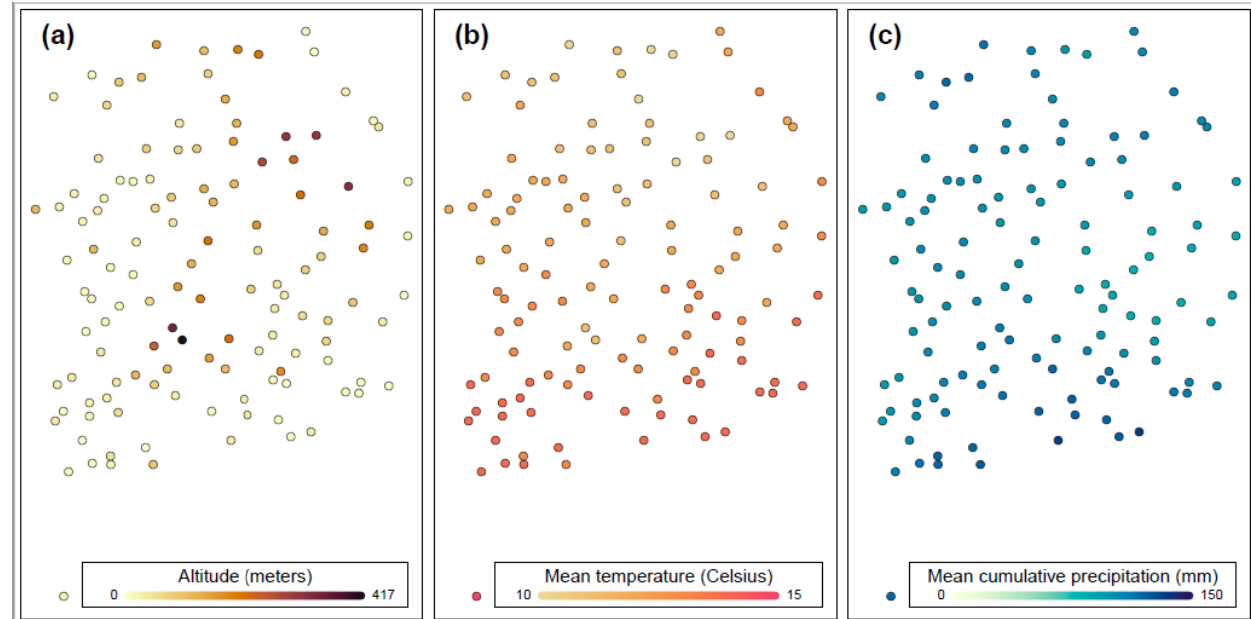
Figure 1. Dispersion of the Hanwoo farms in South Korea with a summary about the locations’ ( a ) altitude (1 – 147 m), ( b ) average temperature (10.0 – 15.3 C), and ( c ) average cumulative precipitation (83.2 – 138.3 mm). Average temperature and precipitation are historical means on measurements between the years 2000 and 2019 [26,27].